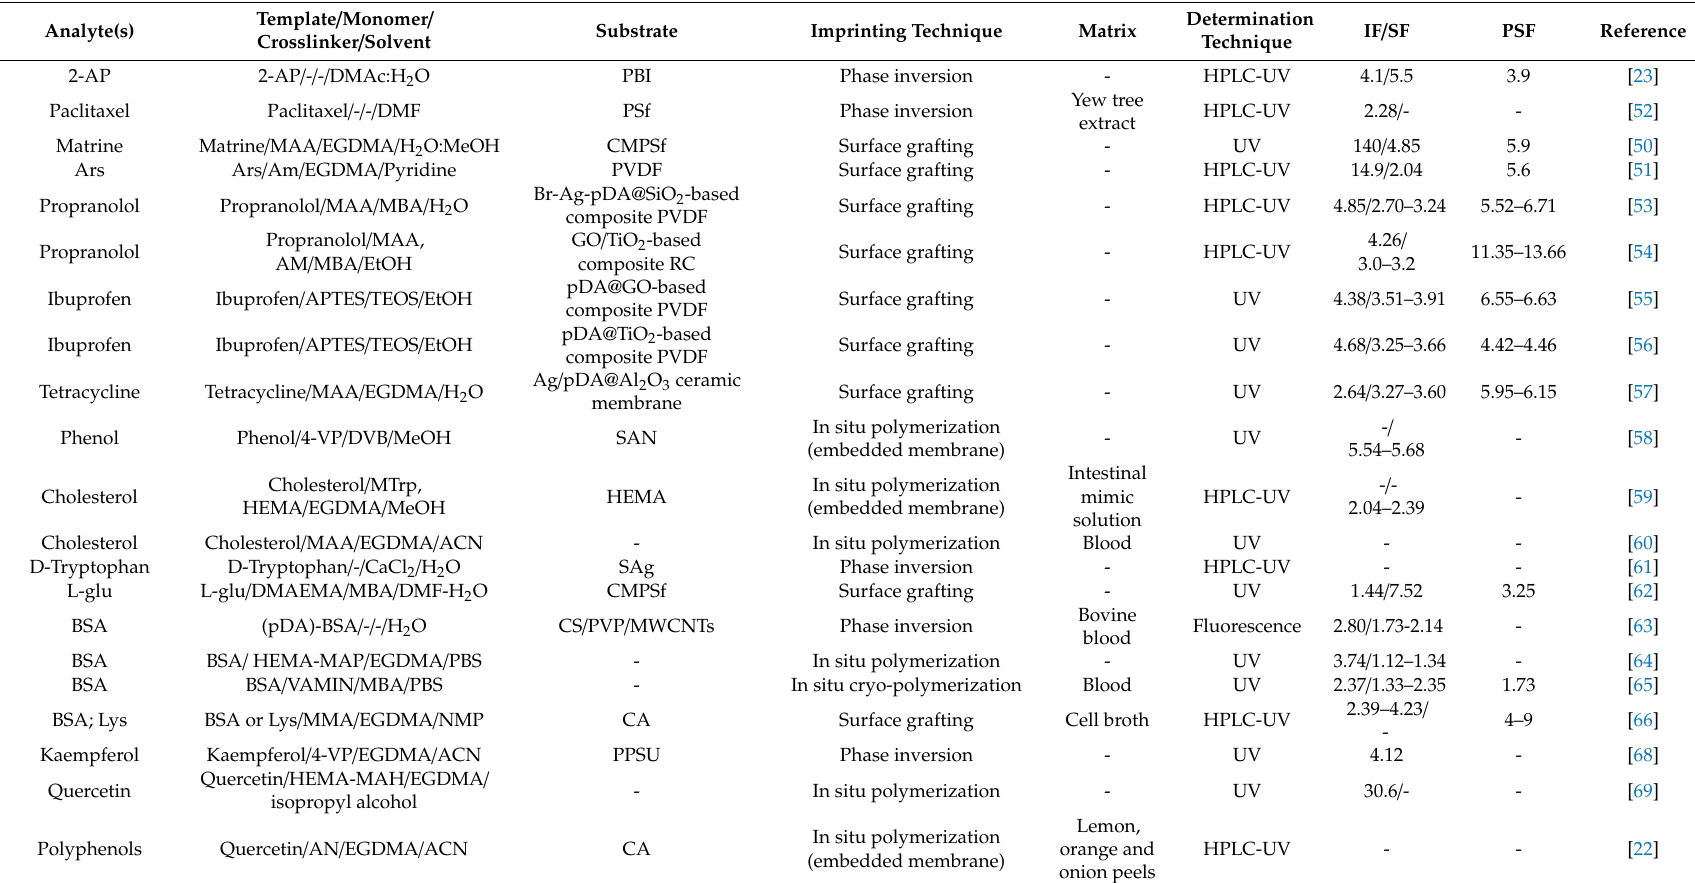
Table 2. Recent applications of MIMs in separation processes in pharmaceutical and food